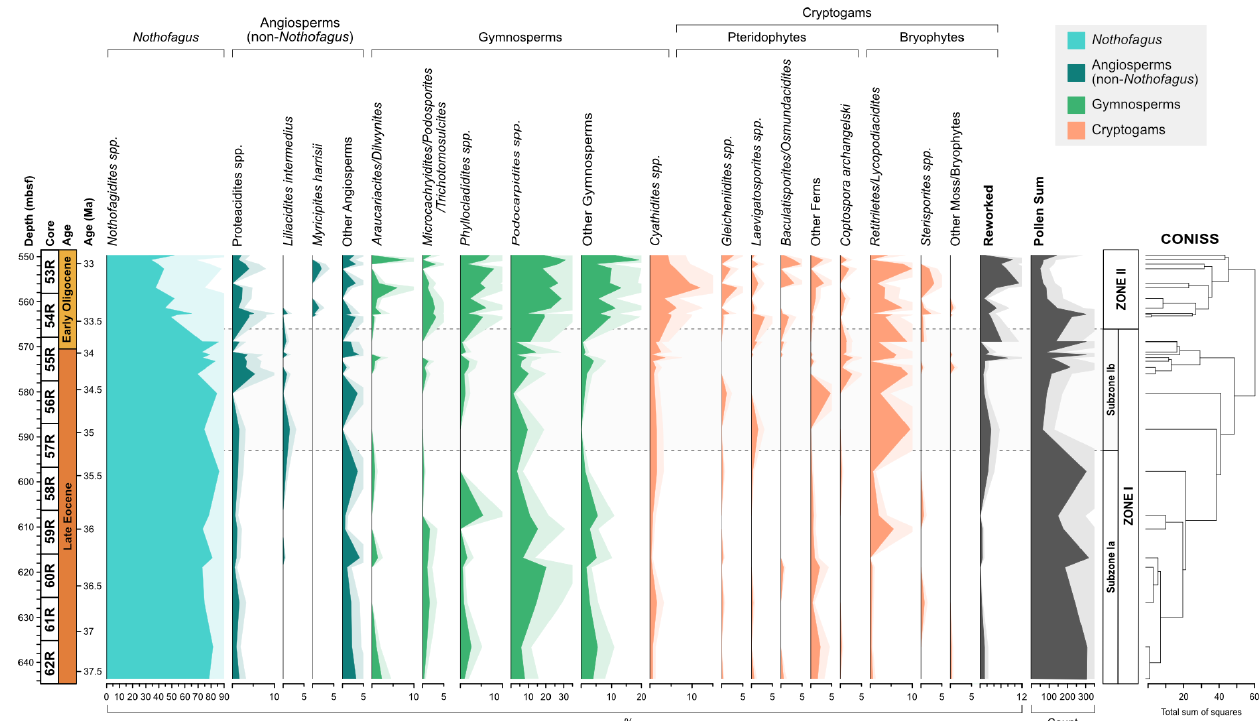
Figure 3. Frequency and stratigraphic distribution of major pollen and spore taxa with CONISS ordination showing two distinct zones (Zone I and Zone II); Zone I is further subdivided based on the occurrence of key taxa. Pollen and spore taxa have been separated into key ecological